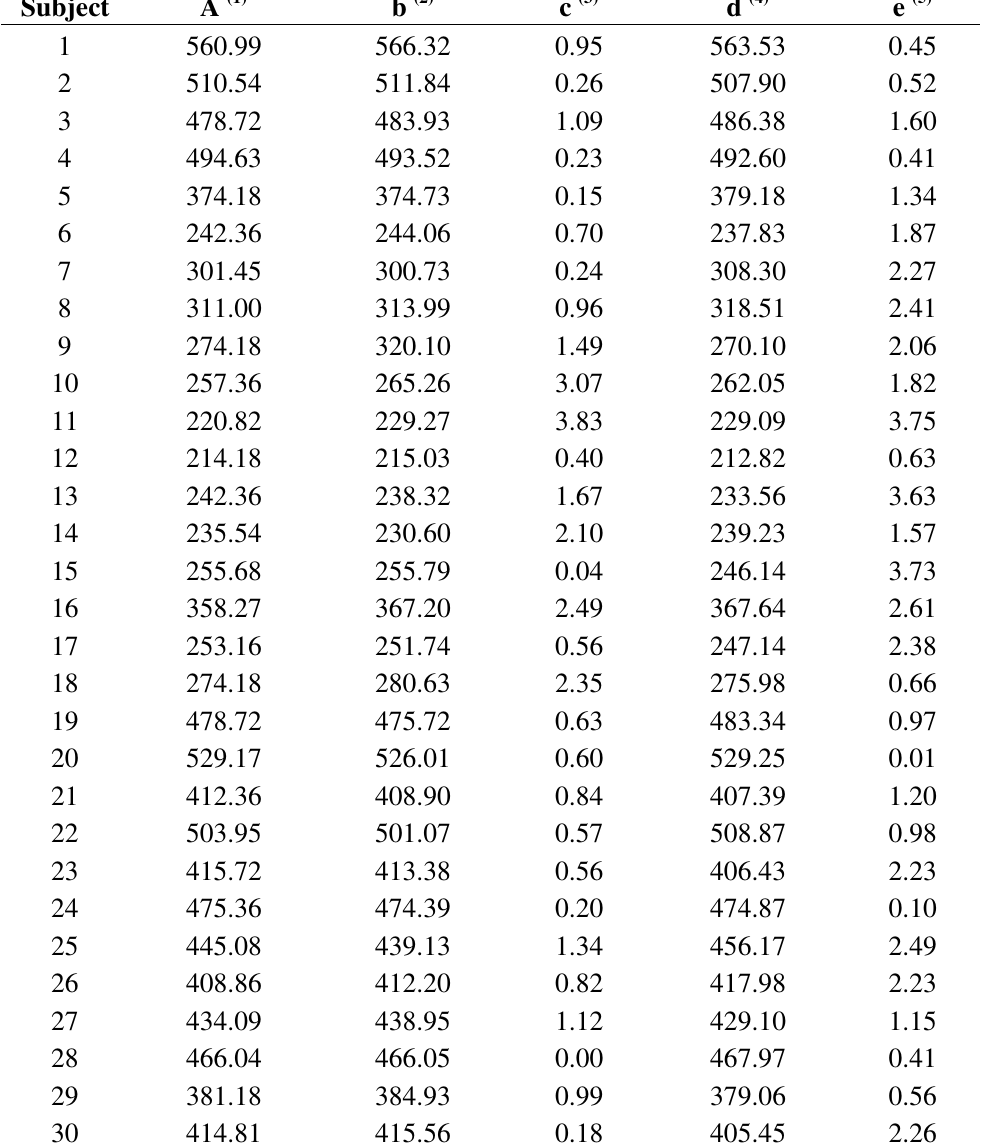
) values in each posture of T